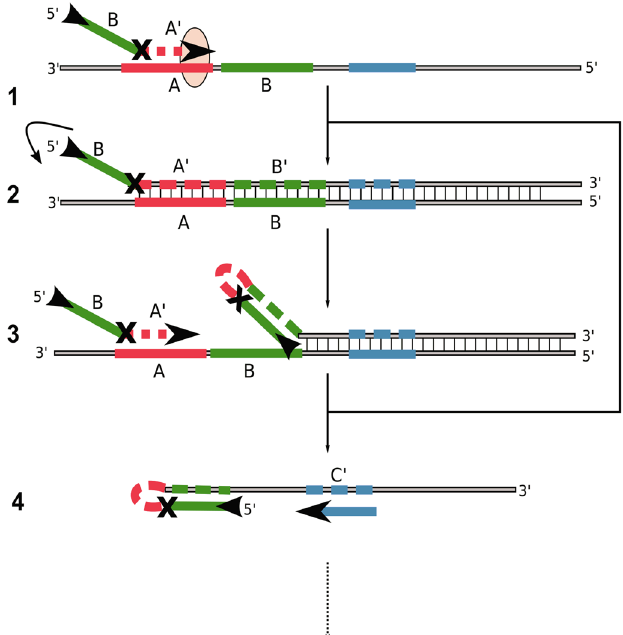
Figure 7. Hinge-initiated primer-based replication with one hinge-primer and PCR-like primer. The hinge- primer anneals to the target region and will be extended to double strand DNA by Bst DNA polymerase (1). The refolding to the thermodynamically more stable hairpin structure liberates the initial priming site (2–3). These steps are repeated and the sense DNA strand will be released. The PCR-like primer can anneal to the priming site and will be extended